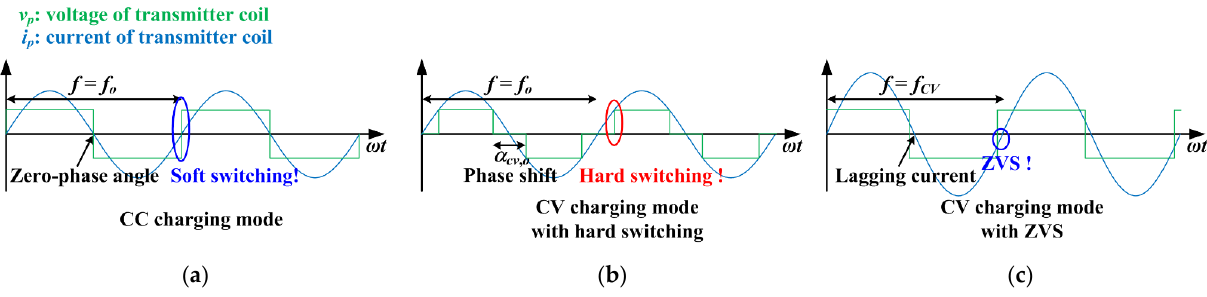
Figure 2. Ideal voltage and current of transmitter coil in ( a ) constant current charging mode without phase shift control at f = f o ; ( b ) constant voltage charging mode at f = f o with phase shift control; ( c ) constant voltage charging mode without phase shift control at f = f CV .